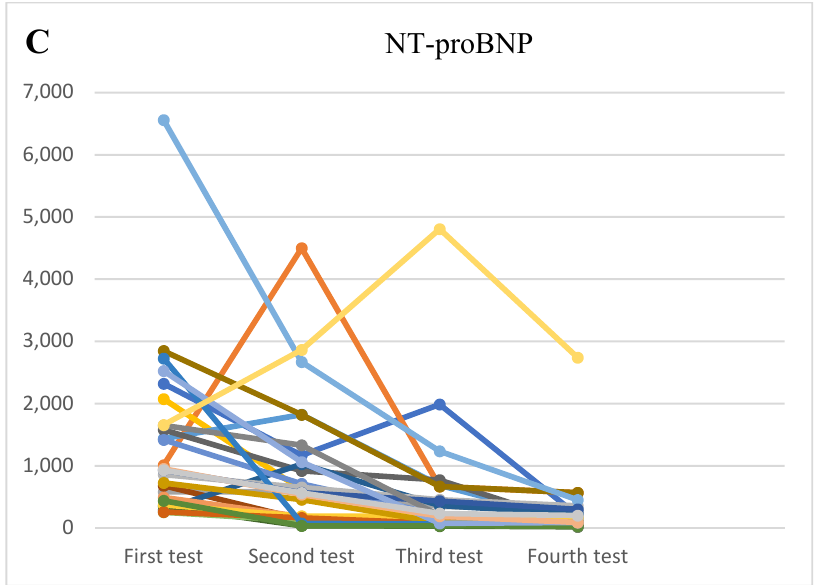
Figure 3. ( A ). The trendline of the values of fibrinogen. ( B ). The trendline of the values of D-dimers. ( C ). The trendline of the values of NT-proBNP.